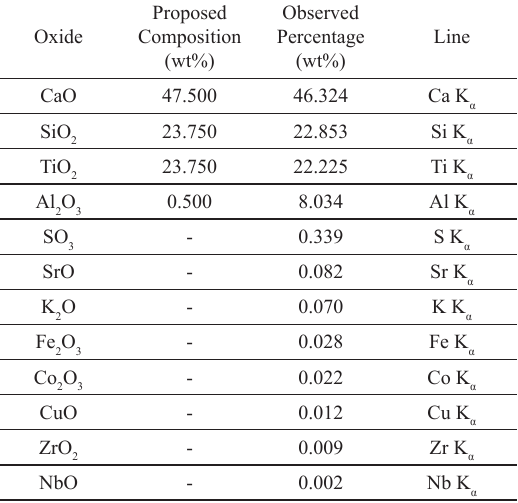
Table 1. Results of semi-quantitative chemical analysis (wt%) of Ca Glass by XRF spectrometry. Oxide